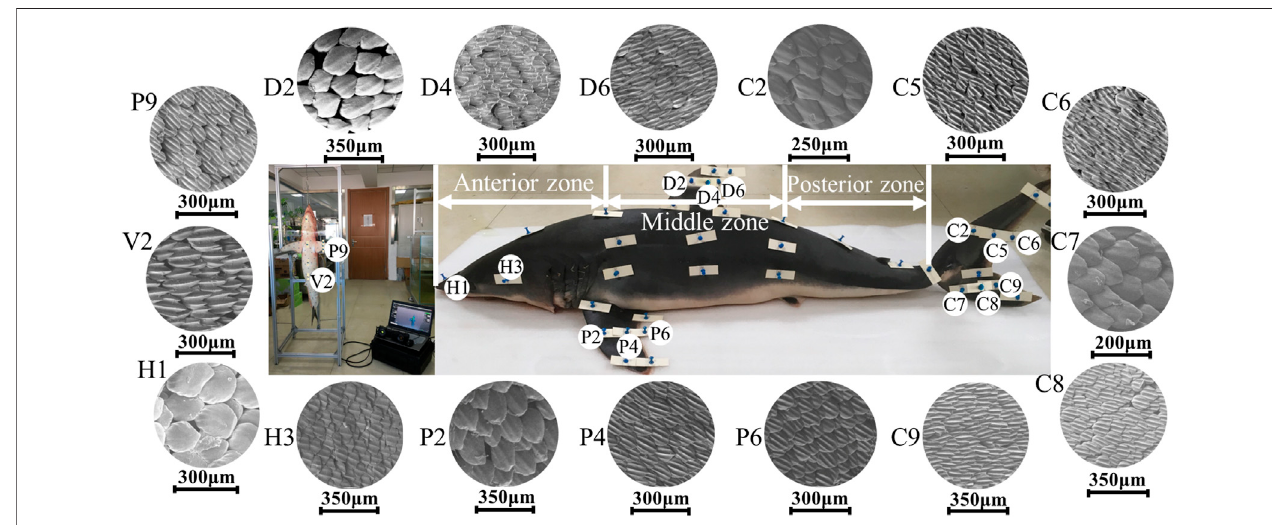
FIGURE 4 | Micrographs (SEM) showing the morphology of scales in shark skin samples.